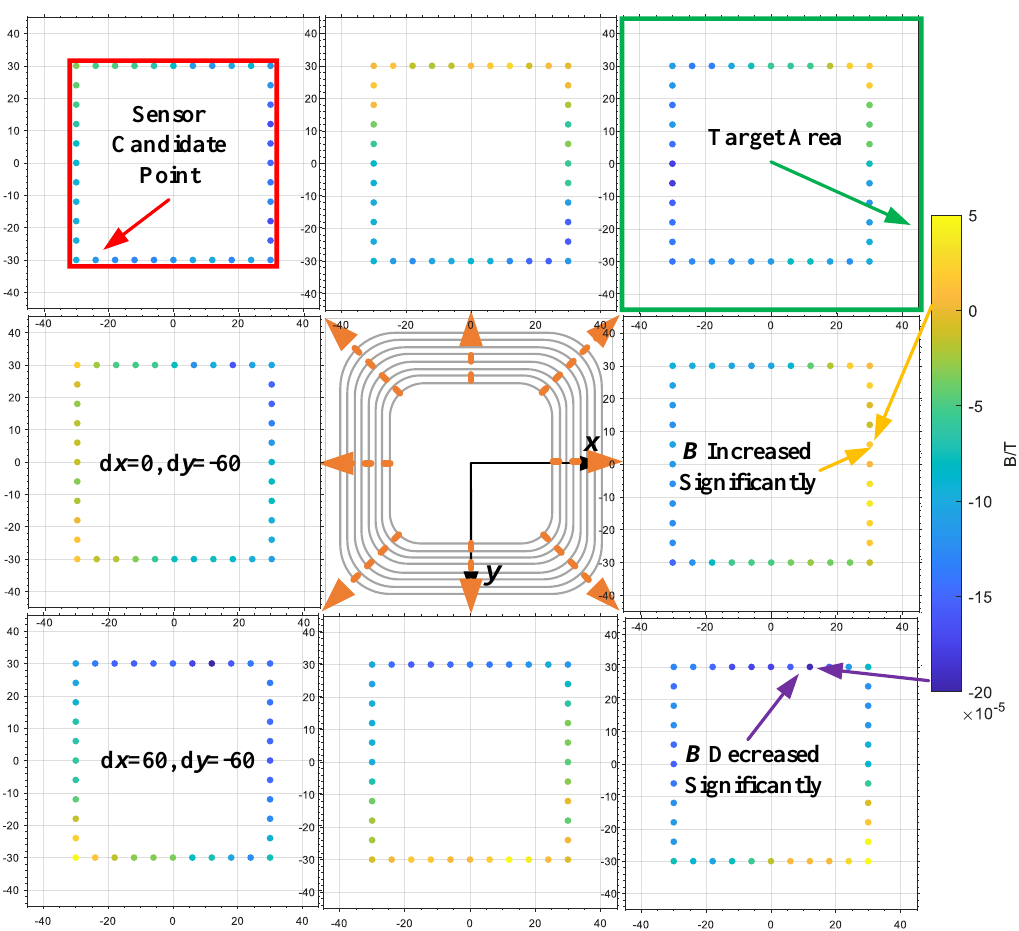
Figure 5. Magnetic field variation law of candidate position under different receiving coil displacement directions.